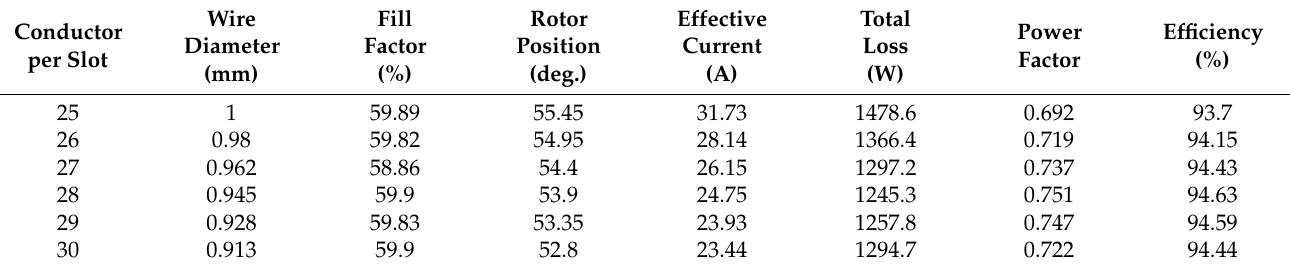
Table 3. Conductor per slot and wire size analyzes.